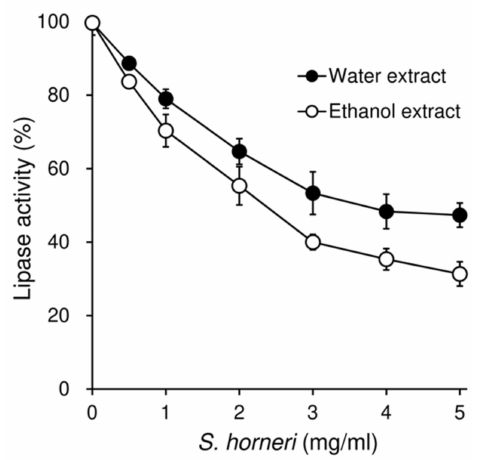
Figure 7. Effects of S. horneri extracts on the activity of pancreatic lipase in vitro. S. horneri was extracted with water (water extract) or 70% ethanol (ethanol extract), and its inhibitory activity was measured in vitro. Each point represents the mean ± SEM of triplicate